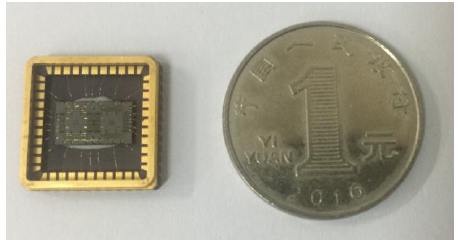
Figure 5. The fabricated MEMS tuning fork gyroscope.